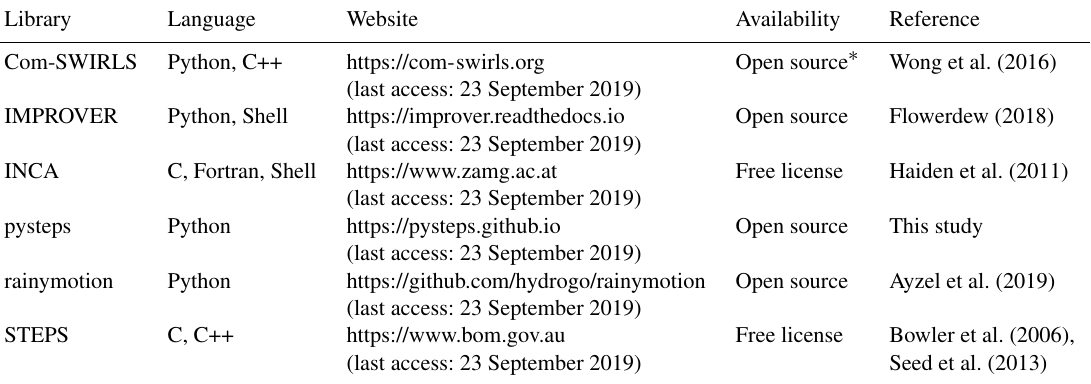
Table 1. Non-exhaustive list (in alphabetical order) of precipitation nowcasting packages that are in principle available to the public. Open- source libraries have their source code available to the general public. Free-license libraries can be obtained upon request.